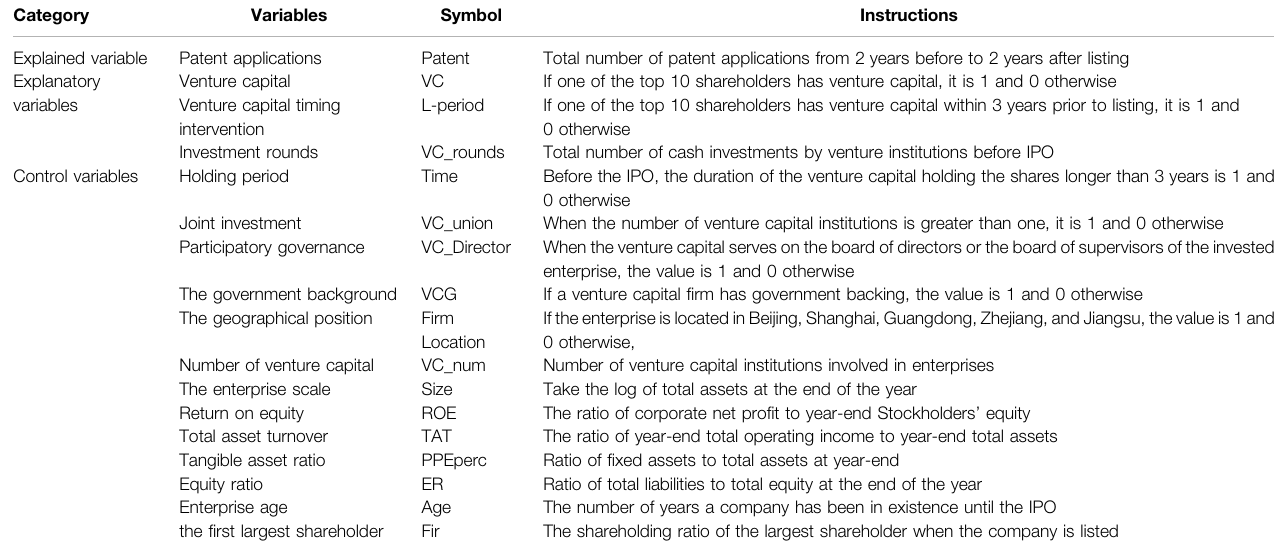
TABLE 1 | Variable selection and